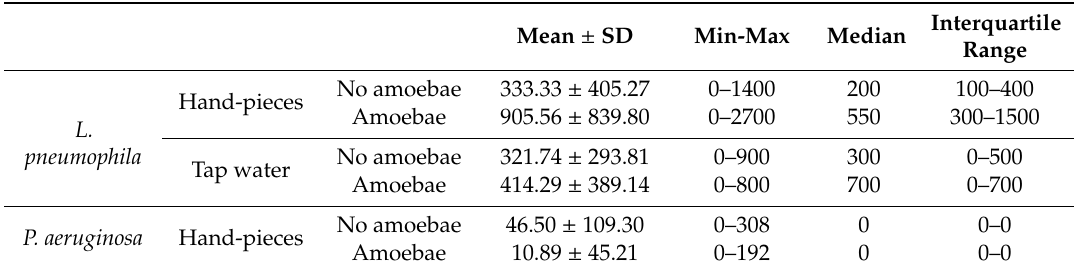
Figure 2. Vermamoeba vermiformis from hand-piece water samples (inverted microscope, 40× objective).